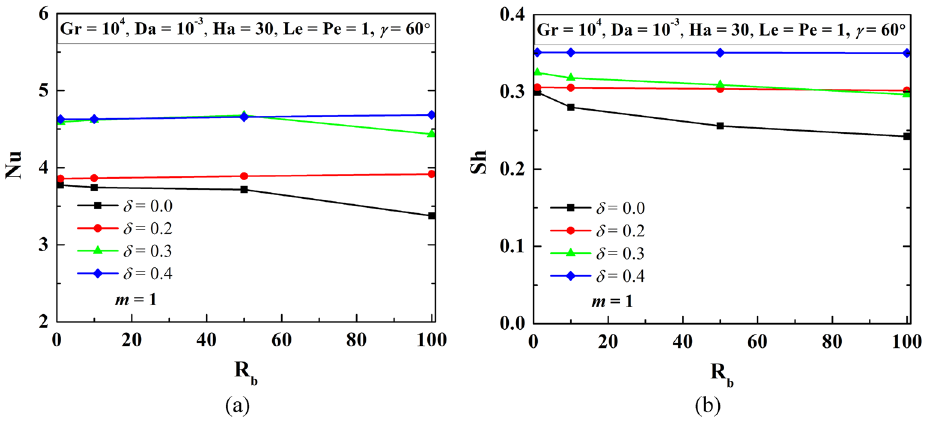
Figure 10. Patterns of average Nu and Sh for different δ and R b at Le = Pe = 1, Gr = 10 4 , Da = 10 –3 , Ha = 30, m = 1, and γ = 60° for W-shaped